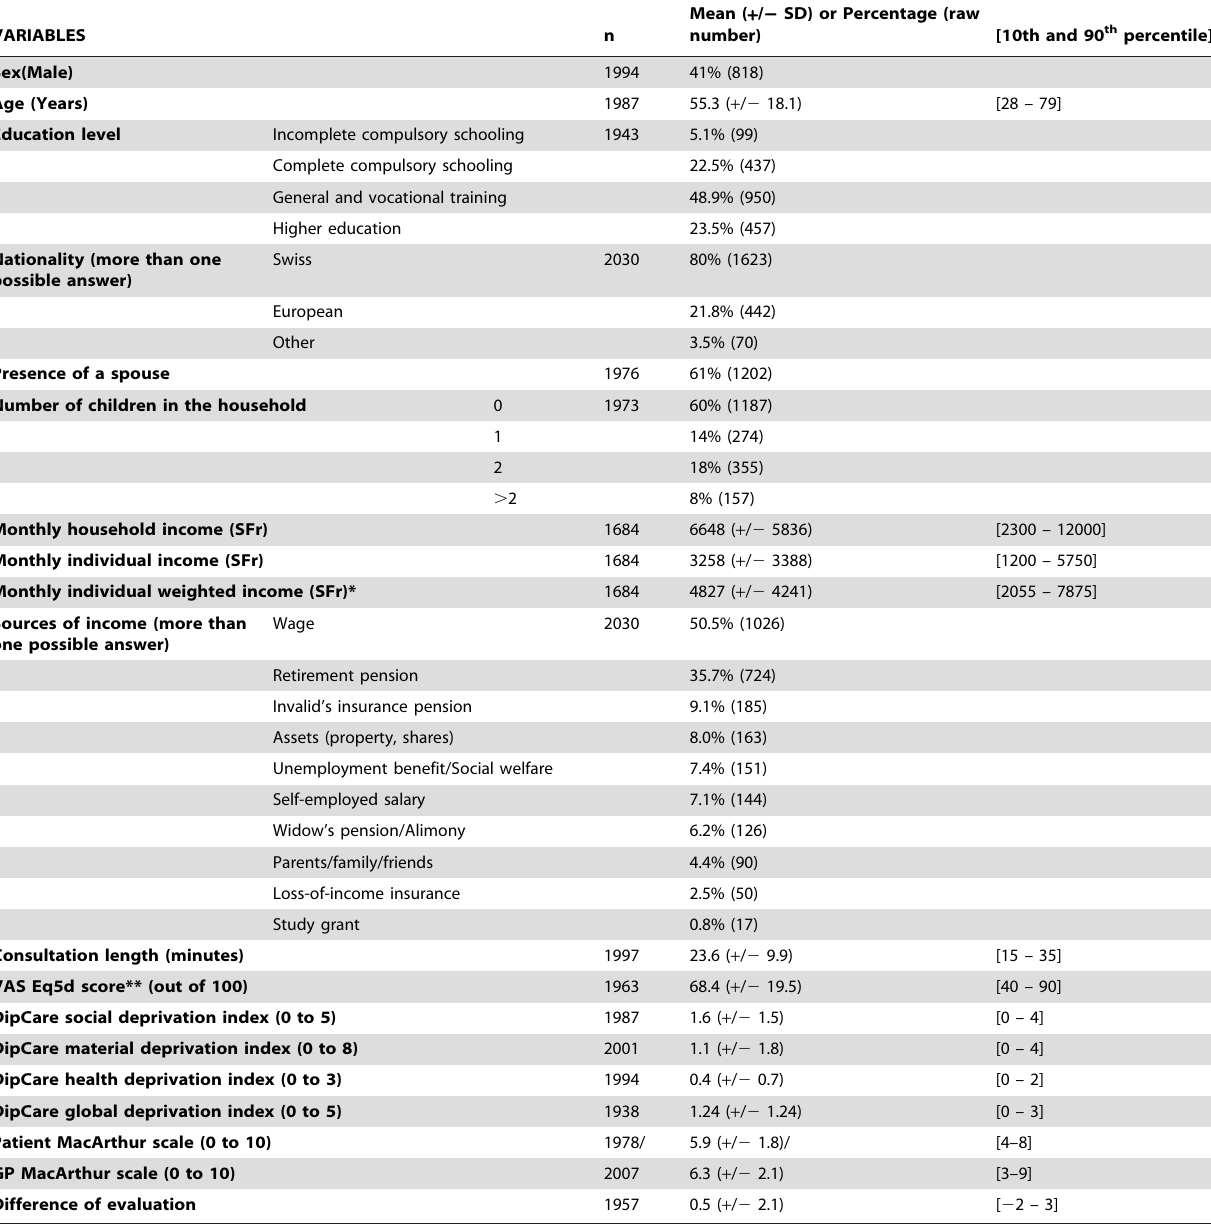
Table 3. Characteristics of the 2030